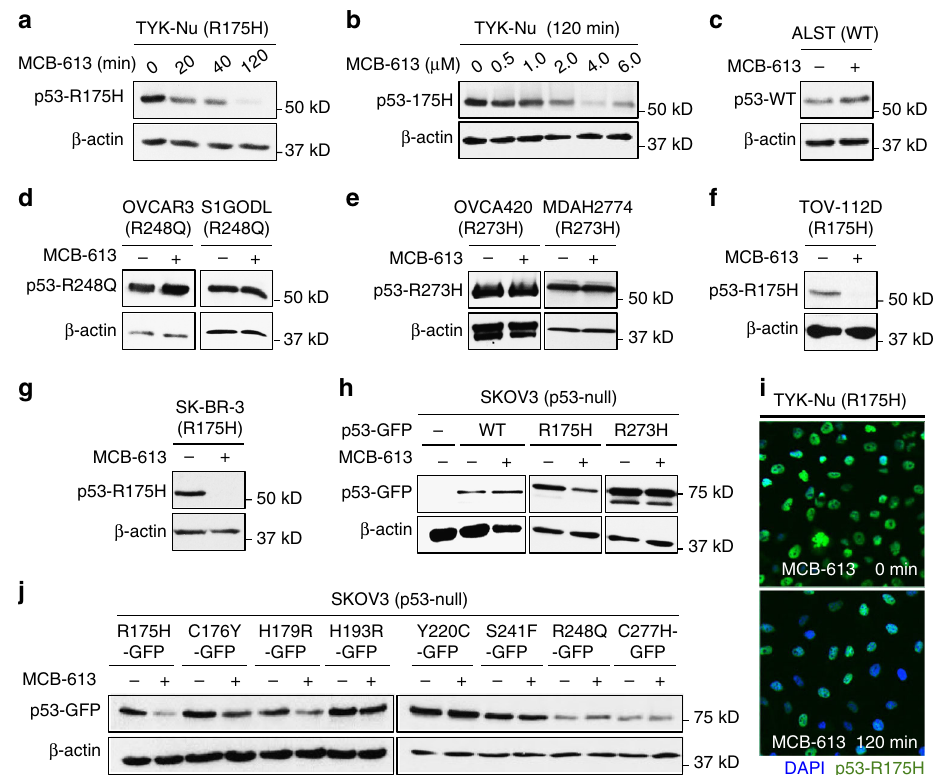
Fig. 1 MCB-613 causes a rapid and selective decrease in the level of p53-R175H. a MCB-613 (6 µ M) caused a rapid decrease in p53-R175H protein levels in TYK-Nu cells. b Effect of different concentrations of MCB-613 (2 h) on p53-R175H levels in TYK-Nu cells. MCB-613 treatment resulted in the decrease in p53-R175H levels in a concentration dependent manner. c p53-WT protein levels in ALST cells slightly increased upon MCB-613 (6 µ M, 2 h) treatment. d , e MCB-613 (2 h) had minimal effect on other GOF mutp53, such as d p53-R248Q levels in OVCAR3 and S1GODL cells, and e p53-R273H levels in OVCA420 and MDAH2774 cells. f , g p53-R175H levels decreased in multiple cell lines upon MCB-613 (2 h) treatment; f TOV-112D (ovarian cancer); g SK-BR-3 (breast cancer). g Effect of MCB-613 (2 h) on GFP-tagged p53-WT, and p53-R175H mutant protein in the p53 − / − SKOV3 cells. h Effect of MCB-613 (2 h) on GFP-tagged p53-WT, p53-R175H, and p53-R273H mutants in SKOV3 cells. i Immuno fl uorescence shows decrease in p53-R175H levels (green) in TYK- Nu cells upon MCB-613 treatment (2 h). j Effect of MCB-613 (2 h) on GFP-tagged p53 GOF mutants in SKOV3